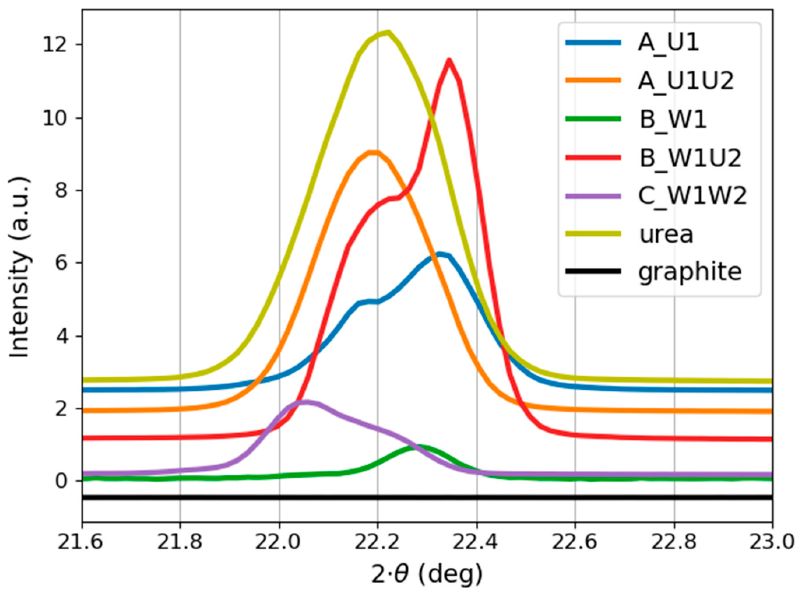
Figure 7. Comparison of 22 ◦ peak appearance for the carbon nanostructures, urea solution, and graphite target. The B_W1 signal was multiplied by 10.